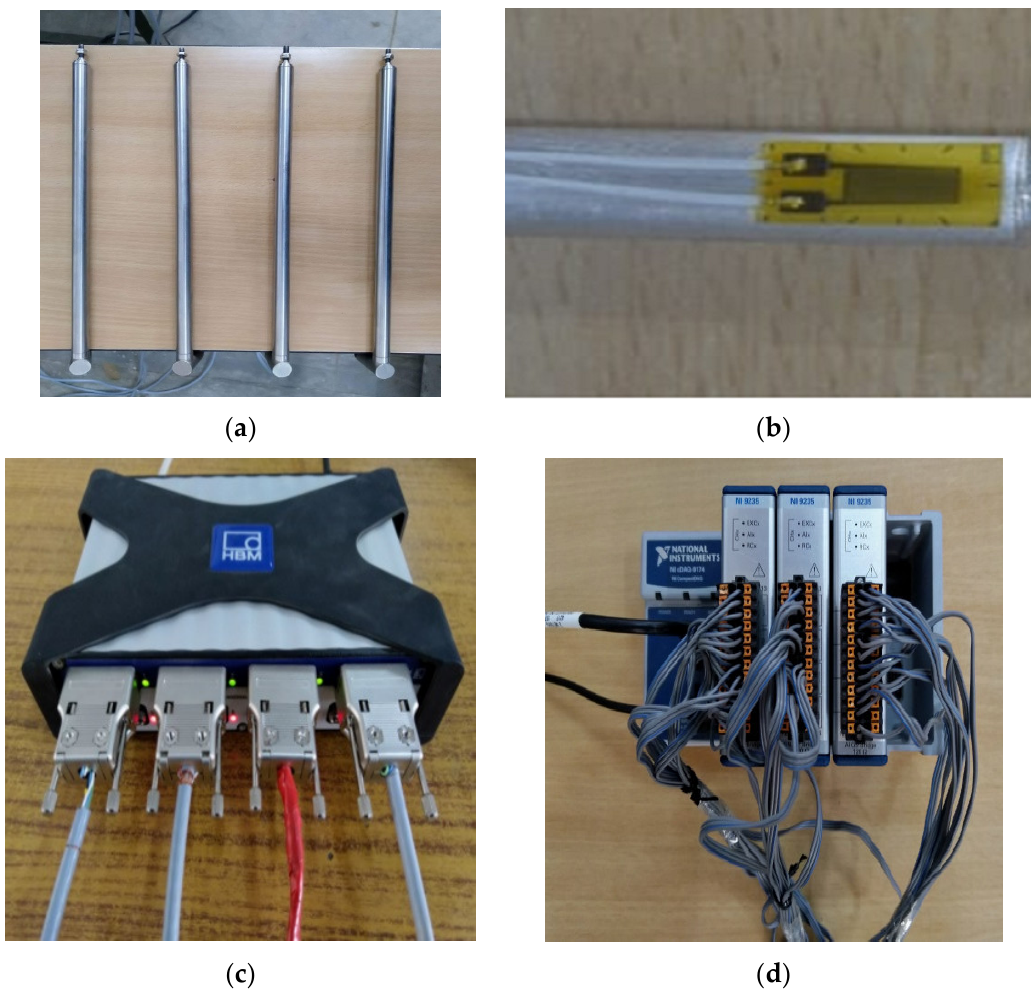
Figure 1. The instrumentation used for measuring the structural response: ( a ) linear variable displacement transducer, ( b ) linear strain gauge, ( c ) data acquisition system MX840B—HBM, and ( d ) a data acquisition system made by National Instruments.